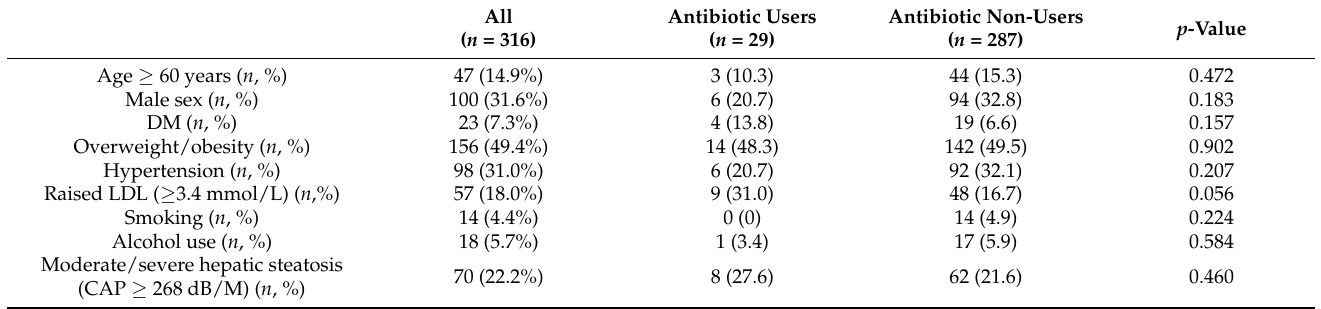
Table 1. Baseline characteristics between antibiotic users and non-users among BNT162b2 recipients.